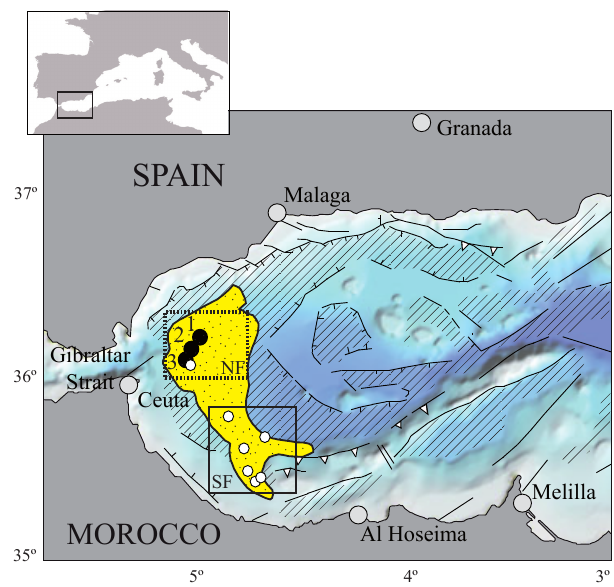
Figure 1. The Alboran Sea showing the location of the Mud Di- apir Province and the Northern (NF) and Southern (SF) MV fields. Black dots correspond to the studied (1) Perejil, (2) Kalinin and (3) Schneider’s Heart MVs; white dots refer to other MVs. Modified after Comas et al.